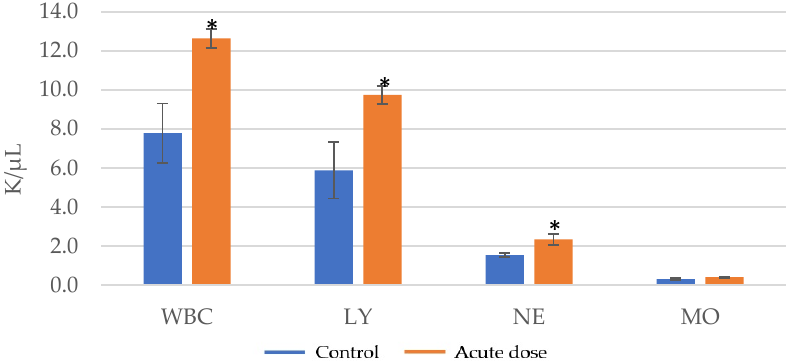
Figure 9. Assessment of leukocyte numbers in acute toxicity testing for the total numbers of leukocytes (WBC), lymphocytes (LY), neutrophils (NE) and monocytes (MO) in mice; * = p value < 0.05.